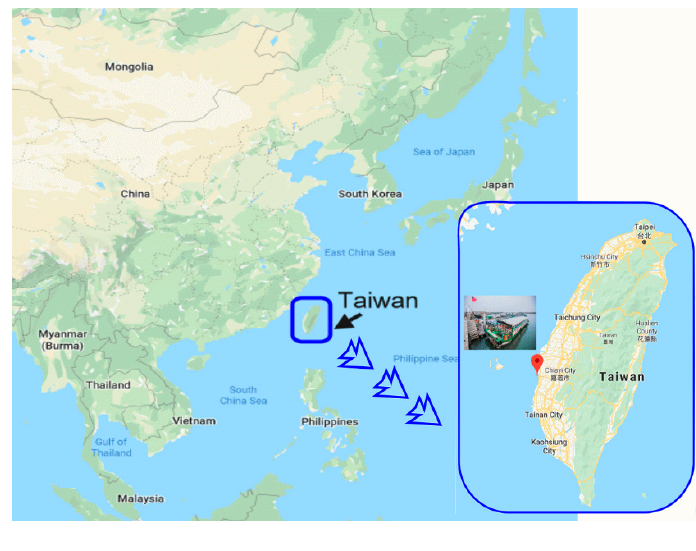
Figure 1. Map of the study area.